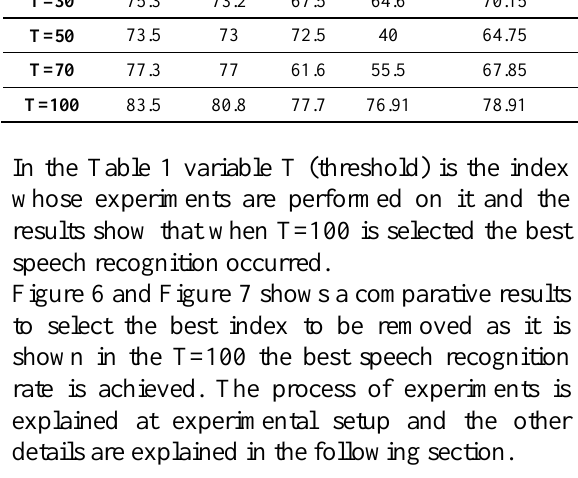
Figure 8. Various α values was experimented and α=0.8 was selected because of better recognition rate in some certain SNR.